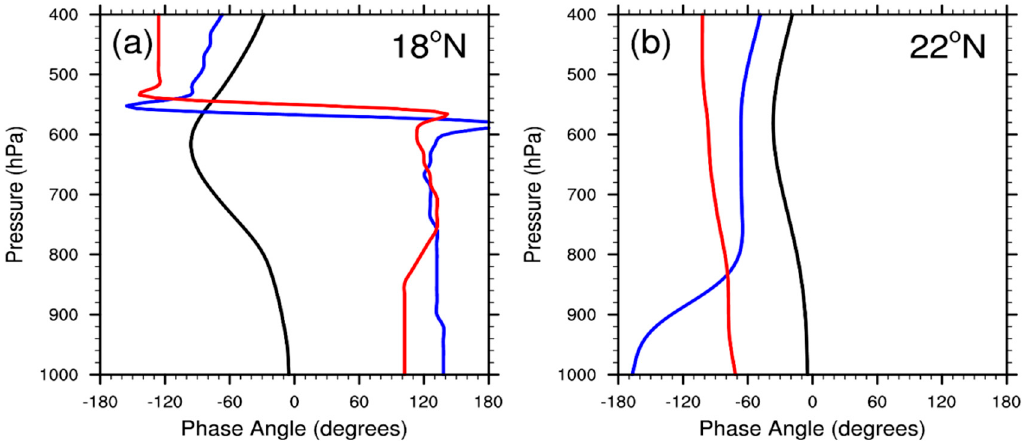
ξ , blue) and dust w